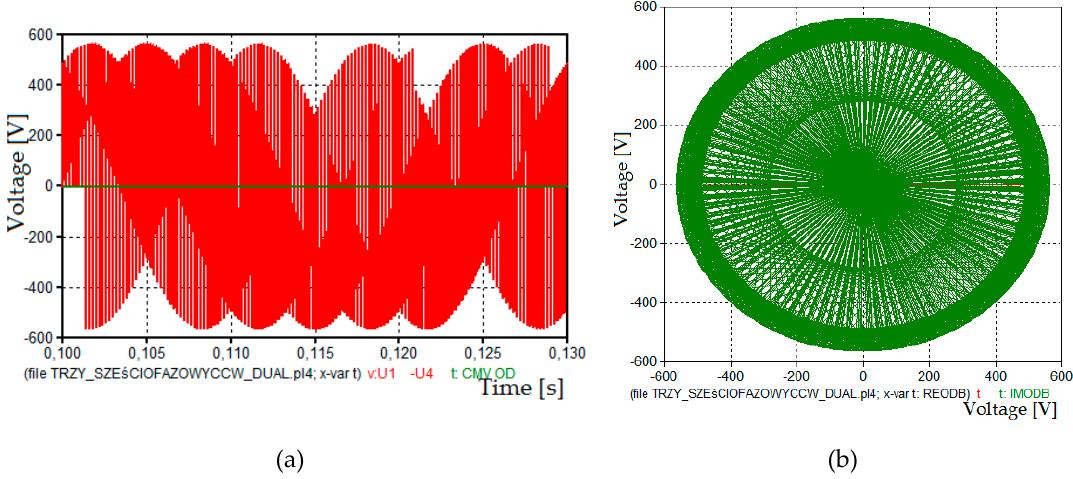
Figure 10. Waveforms of the load voltages (red lines) and the CMV load (green colour), ( a ) and trajectory of the load phase voltage ( b ), synthesized in the MC controlled by the use of the CCW rotating space vectors, for three ‐ phase open ‐ end load and output frequency of 30 Hz.